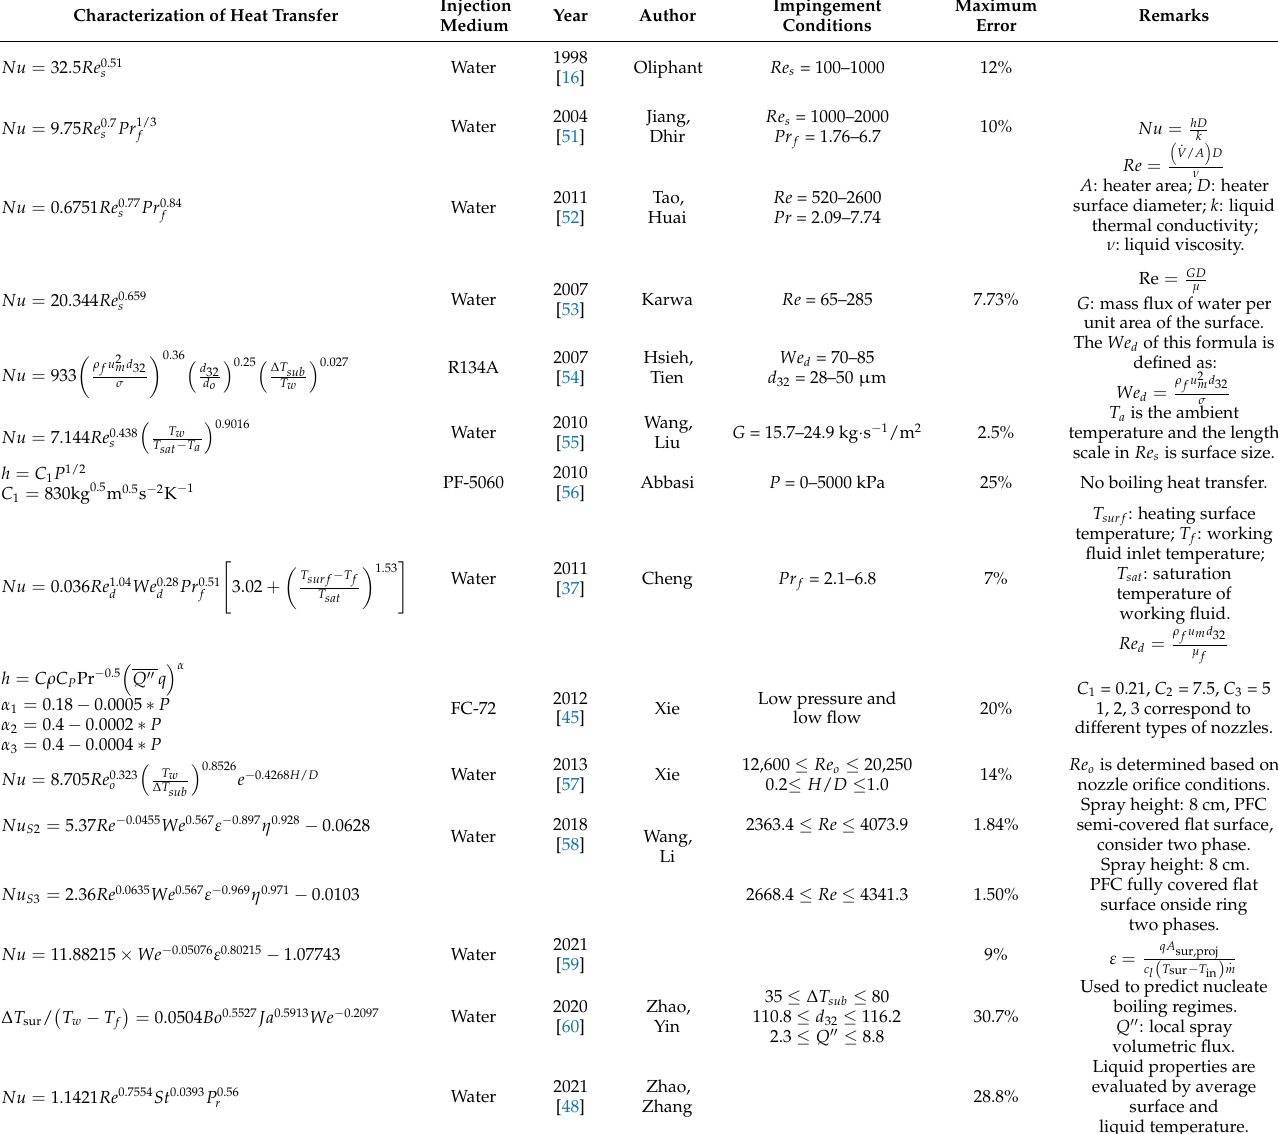
surface and liquid